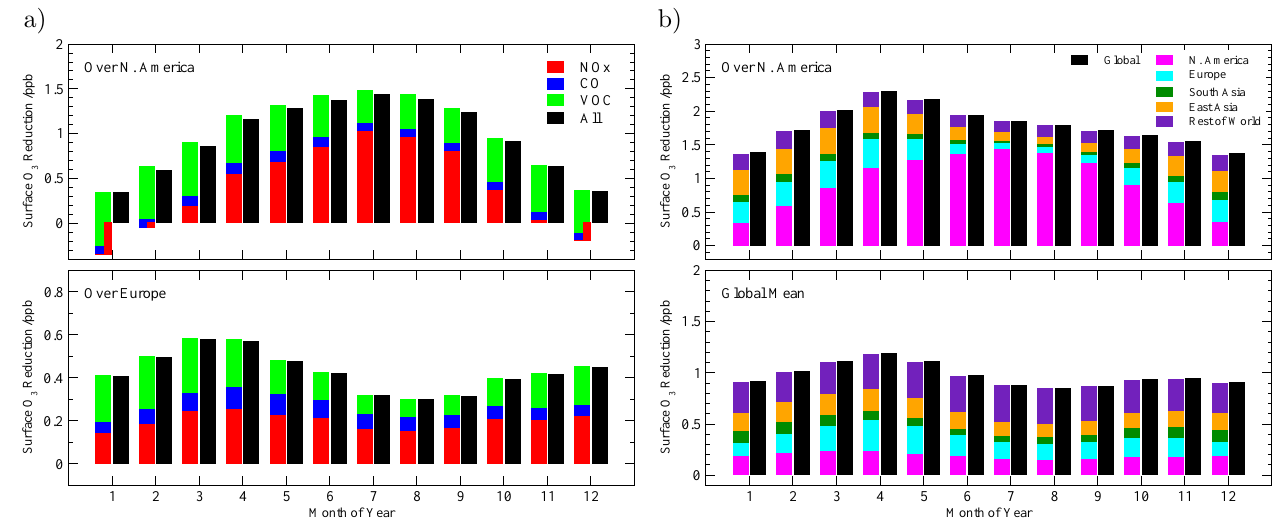
Fig. 2. Tests of linearity with the FRSGC/UCI CTM. (a) Sum of O 3 responses from 20% reductions in anthropogenic NO x , CO and VOC emissions from North American sources compared with responses from a combined 20% emissions change, shown over the source region (upper panel) and a distant receptor region (Europe, lower panel). The contribution from NO x is negative over the source region in winter, partly compensating for the effects of CO and VOC emissions. (b) Sum of O 3 responses from combined 20% emission reductions over each of the HTAP regions and over the rest of the world compared with the response from a global emission change, shown over a single region (N. America, upper panel) and over the globe (lower